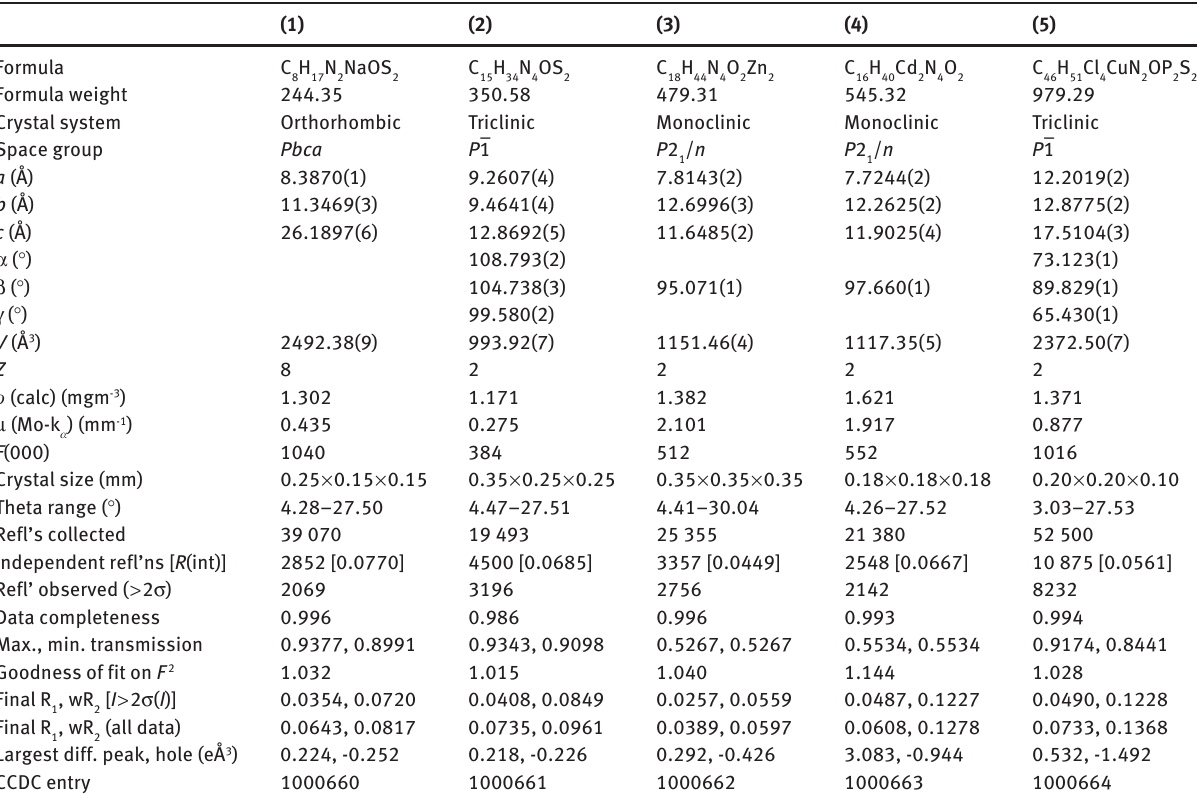
Table 1: Crystal data and structure refinement for 1–5